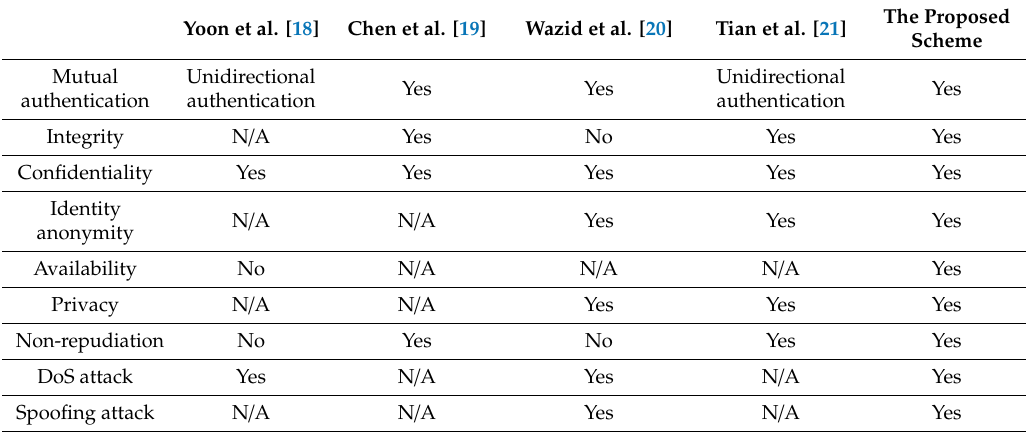
Table 2. Comparison of security issues.